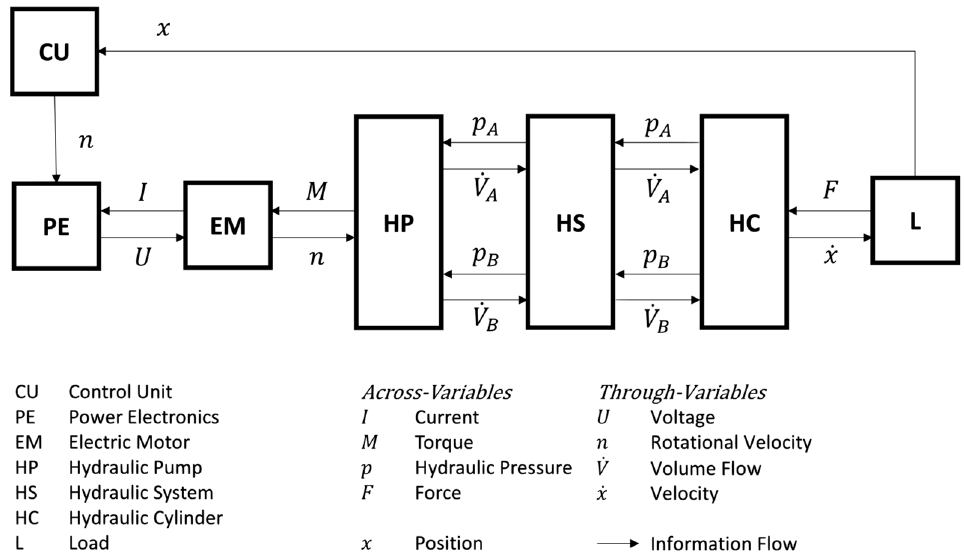
Figure 1. The system structure of the EHA is based on [31]. The central element is the control unit (CU), which is optimized within the scope of this paper. (CU), which is optimized within the scope of this